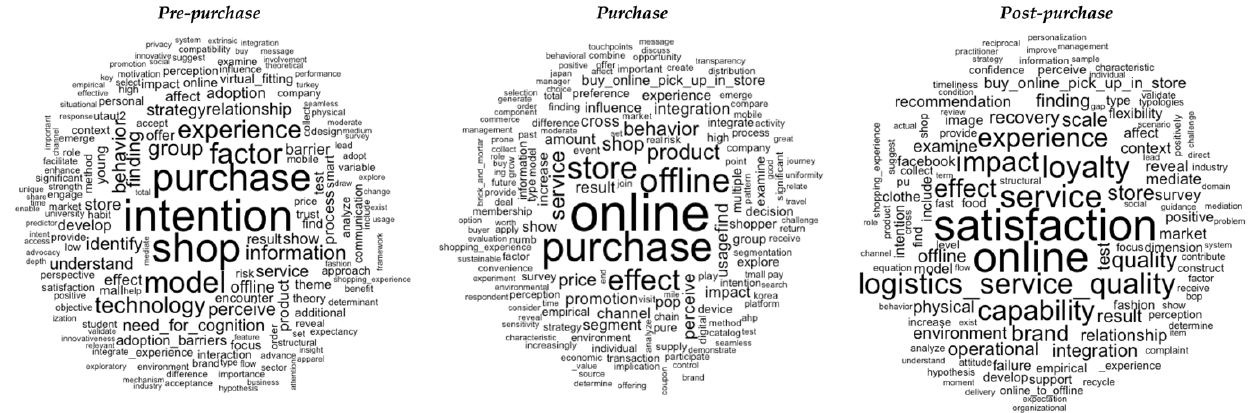
Figure 9. Word cloud for each purchase stage.